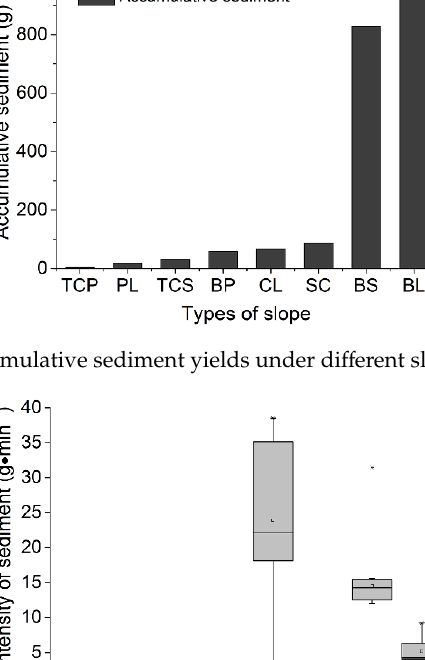
Figure 9. Average intensity of sediment yield with different slope treatments.